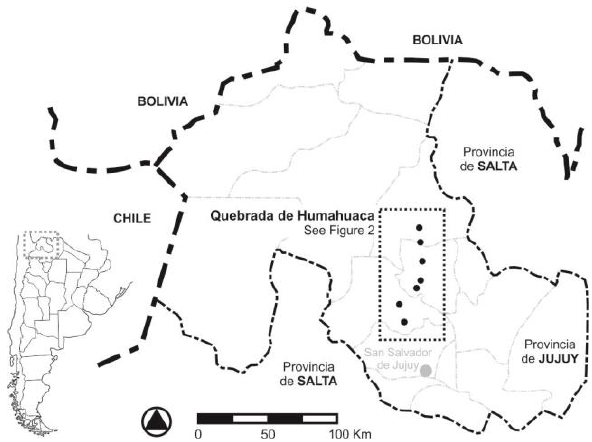
Figure 1. Location of Quebrada de Humahuaca in the province of Jujuy ©